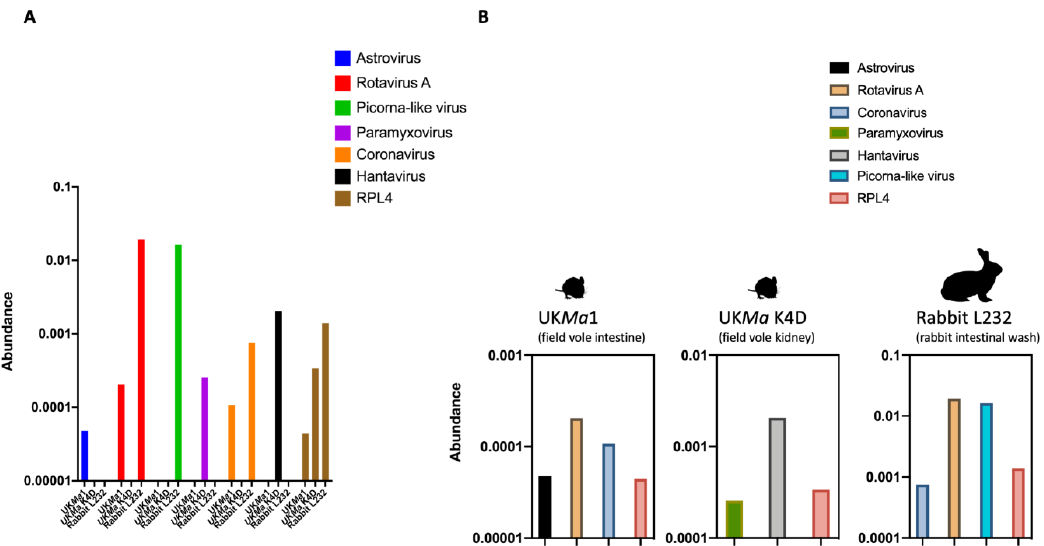
Figure 2. Overview of viral reads identified in this study. ( A ) Host associations (UK Microtus agrestis gut (UK Ma 1), UK Ma K4D and rabbit L232) with the viral reads identified in this study: astrovirus, rotavirus A, picorna-like virus, paramyxovirus, coronavirus, hantavirus and host reference gene ribosomal protein L4 ( RPL4 ). ( B ) Individual representation of the abundance of viral reads in each animal sample, measured as a percentage of viral reads in log10 scale.